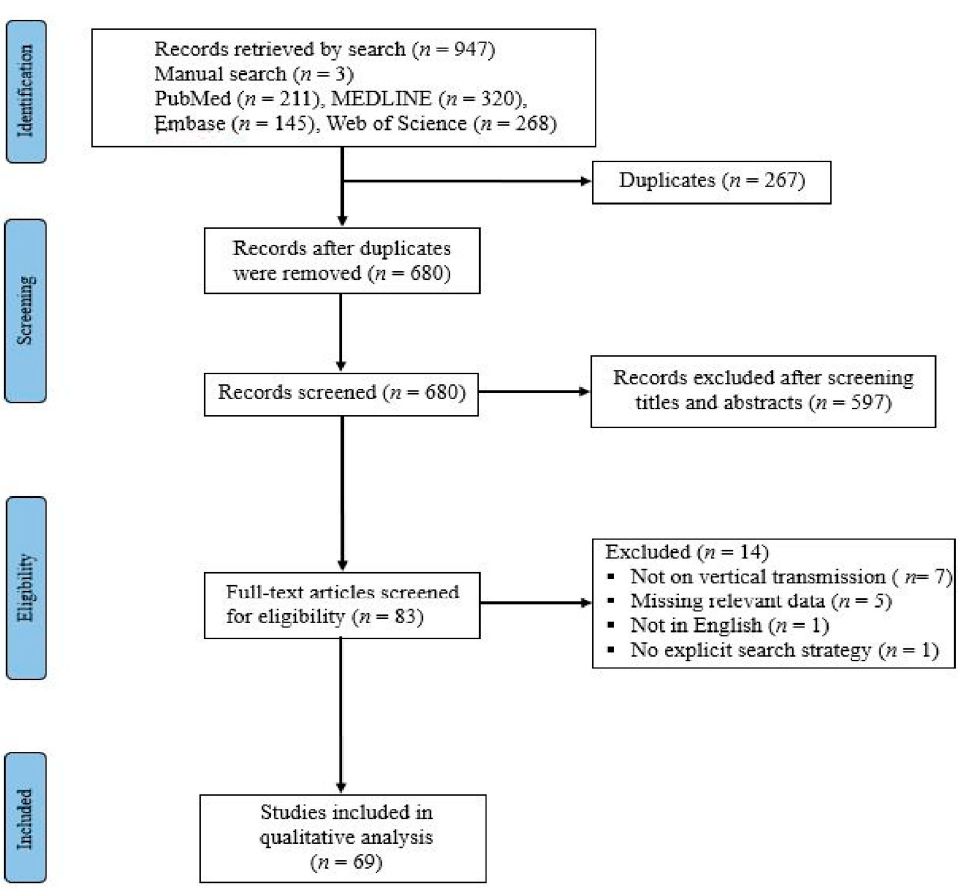
Figure 1. PRISMA diagram for the search and selection processes of the